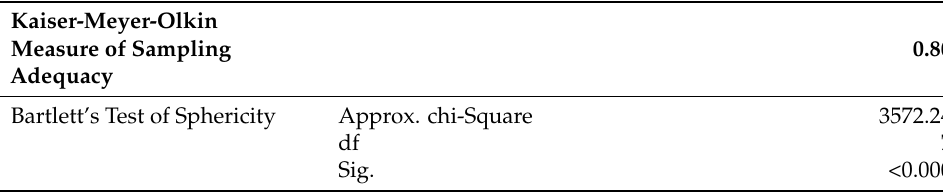
Table A4. KMO and Bartlett’s Test.